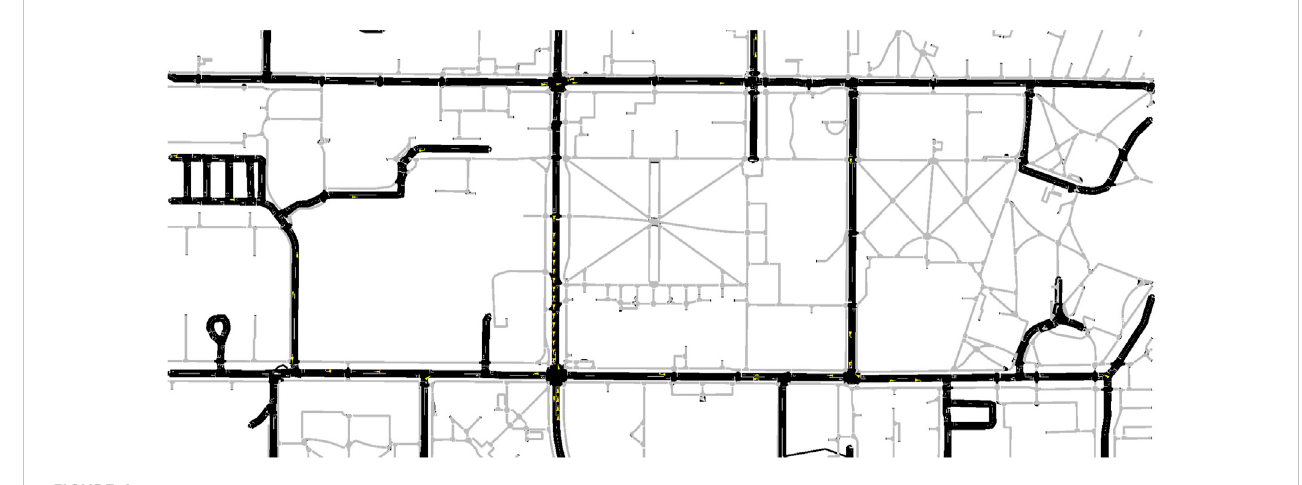
FIGURE 4 Screenshot of a running SUMO-Simulation.